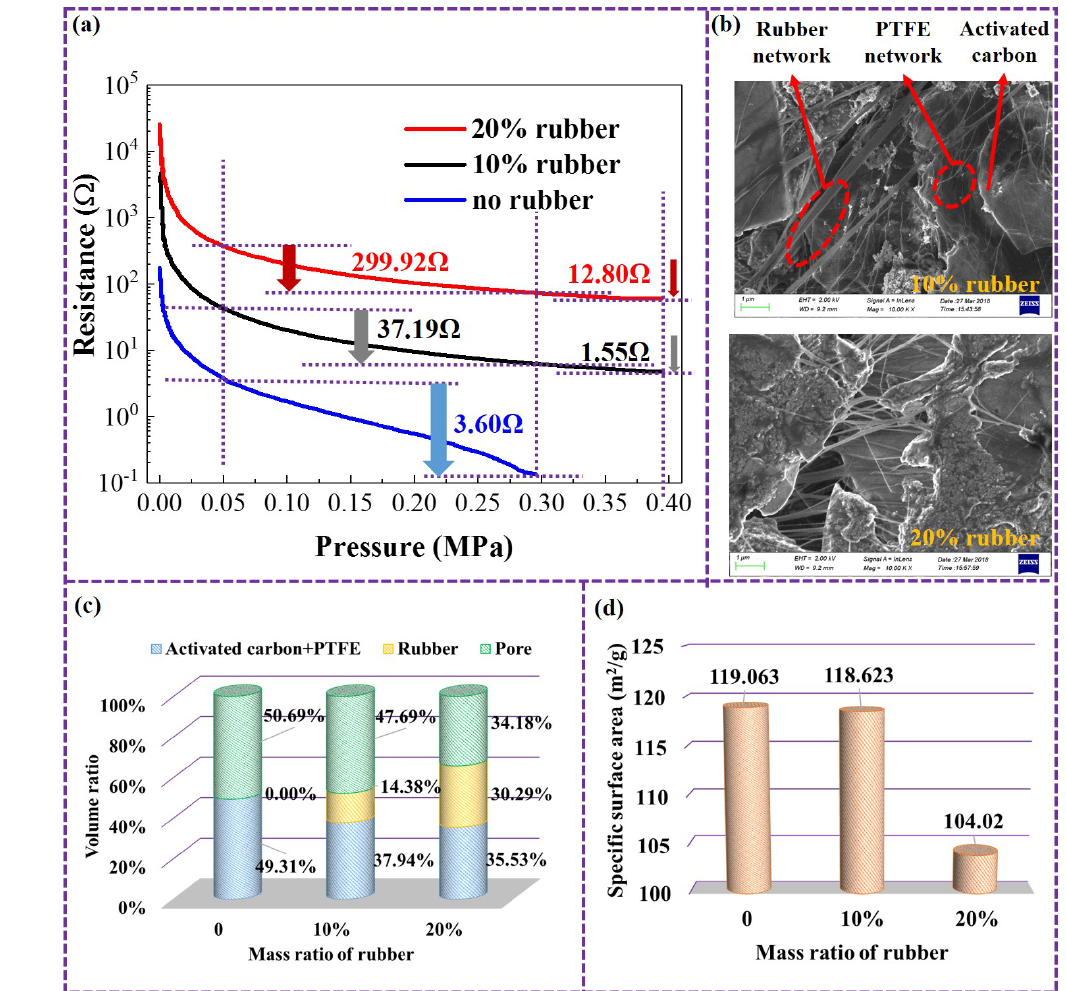
Figure 4. Changes in the microstructure and macroscopic properties of the porous electrodes by adding elastic rubber. ( a ) Piezoresistive characteristics of electrodes with different mass ratios of rubber. ( b ) Electron micrograph of the electrodes with different mass ratios of rubber. ( c ) Volume ratio of electrodes with different mass ratios of rubber. ( d ) Specific surface area of electrodes with different mass ratios of